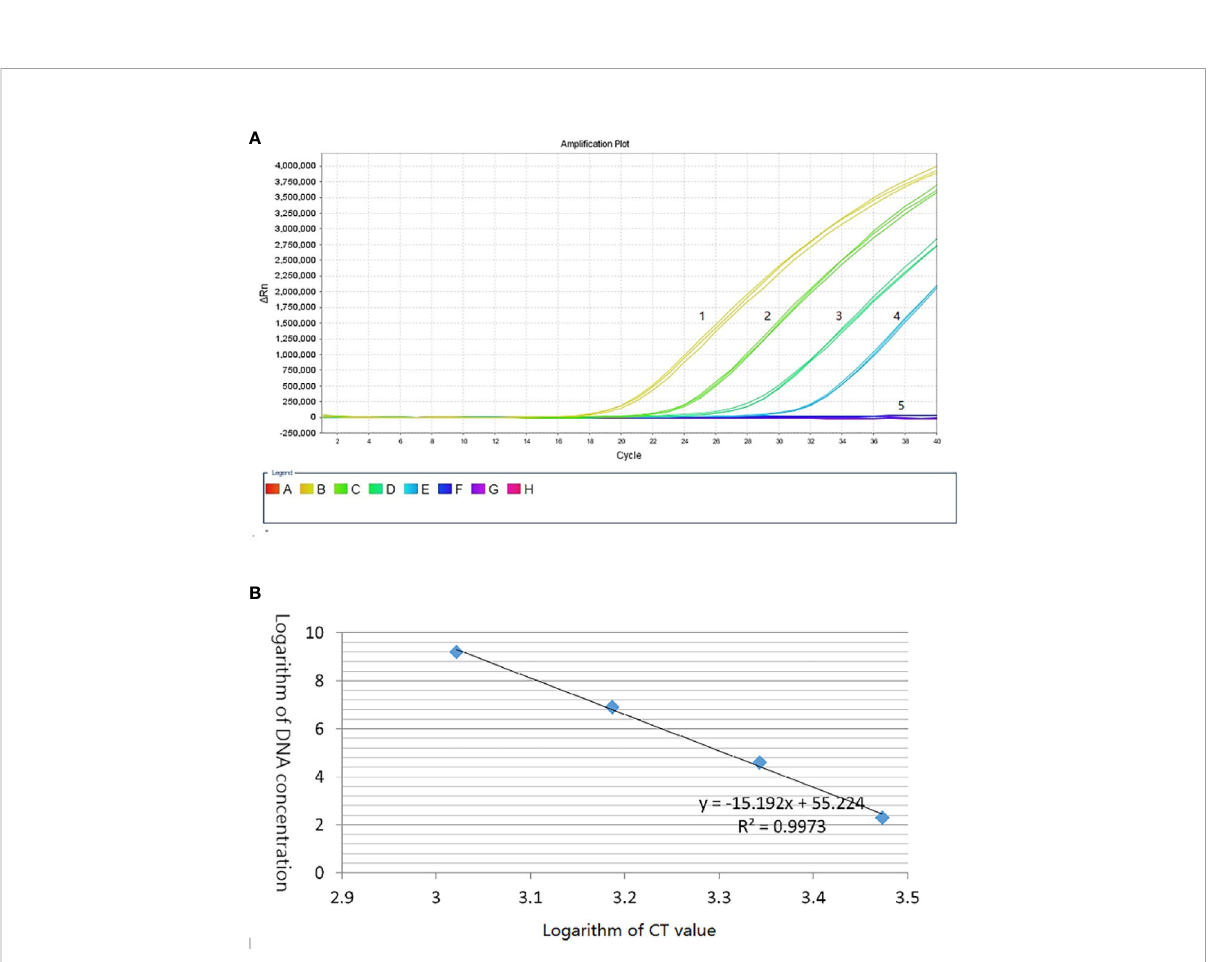
FIGURE 5 Establishment of T. caries standard curve by SYBR Green I real-time PCR. (A) Quantitative real-time ampli fi ed curves. Lanes 1 – 4: tenfold dilutions of recombinant plasmid DNA (2.4 pg – 0.24 fg); lane 5: negative control (ddH 2 O). (B) Standard